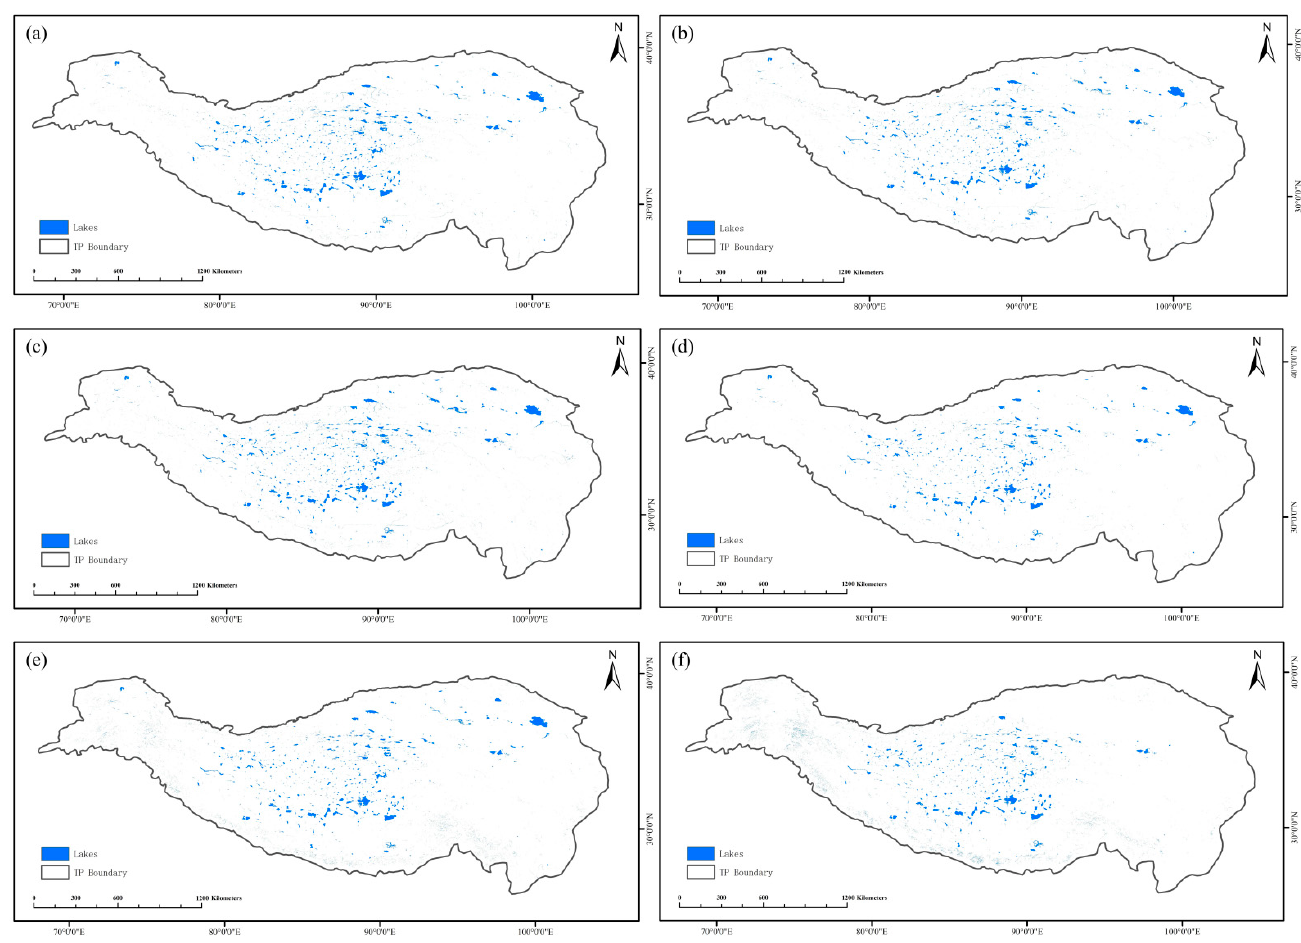
Figure 7. The distribution of lakes on the Tibetan Plateau extracted by different classification methods and characteristic indexes: ( a ) GBDT extraction maps in 2021, ( b ) RF extraction maps in 2021, ( c ) Cart extraction maps in 2021, ( d ) GBDT extraction maps in 2016, ( e ) RF extraction maps in 2016, and ( f ) Cart extraction maps in 2016.